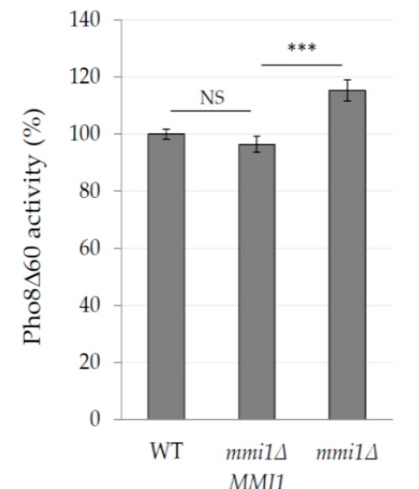
Figure 4. The increased rapamycin-induced autophagy in the mmi1 ∆ strain can be rescued by wild-type MMI1 gene. Exponentially growing cells of the WT, mmi1 ∆ , and mmi1 ∆ MMI1 strains expressing Pho8 ∆ 60 (OD 600 ≈ 0.8) were treated with 200 nM rapamycin for 24 h and the specific Pho8 ∆ 60 was determined. Results are expressed as means ± SD from two independent experiments performed in duplicates (n = 4). The statistical evaluation was performed by using two way analysis of variance (ANOVA). *** p < 0.001; NS; not significant.